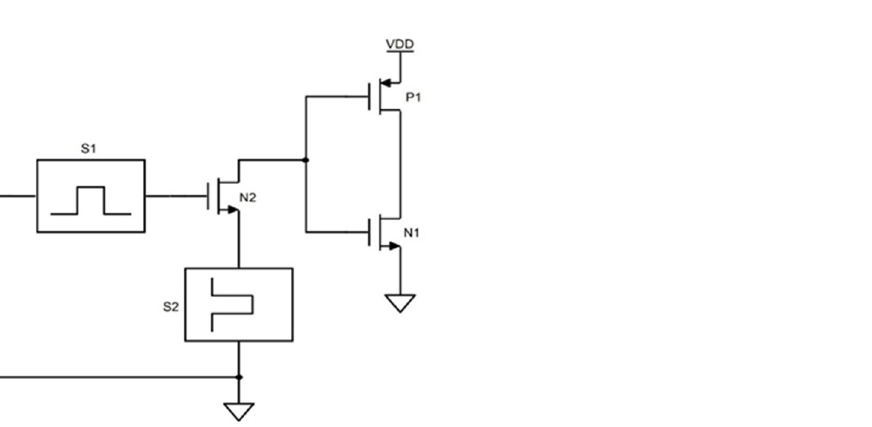
Figure 3. Proposed time-dependent driver circuit which replaces the precharge circuit and sense amplifier to read/write the bit cell.